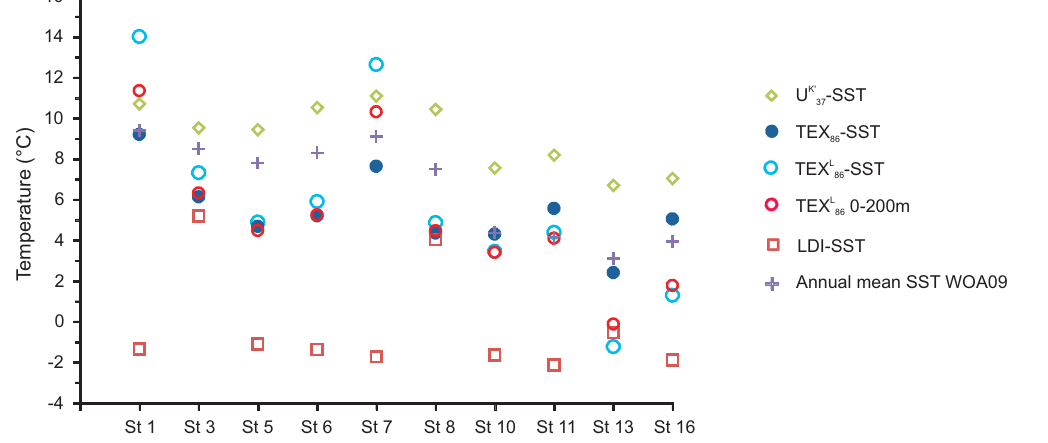
(cid:48) Figure 4. Changes in temperatures derived from U K (green line and diamonds), TEX 86 (dark blue line and open circles), TEX L 37 blue line and open circles), TEX L 0–200m (light red line and open circles), and LDI (brown line and open squares) in descending particles 86 over one complete annual cycle, from July 2011 to July 2012. Numbers refer to sampling intervals specified in Table 2, and data points represent the center of collection intervals. Satellite temperatures (from AVHRR, NOAA) at St 1 during the sampling period are indicated with a dashed orange line and 0–200 mean temperatures from WOA09 are indicated with a dashed purple line.